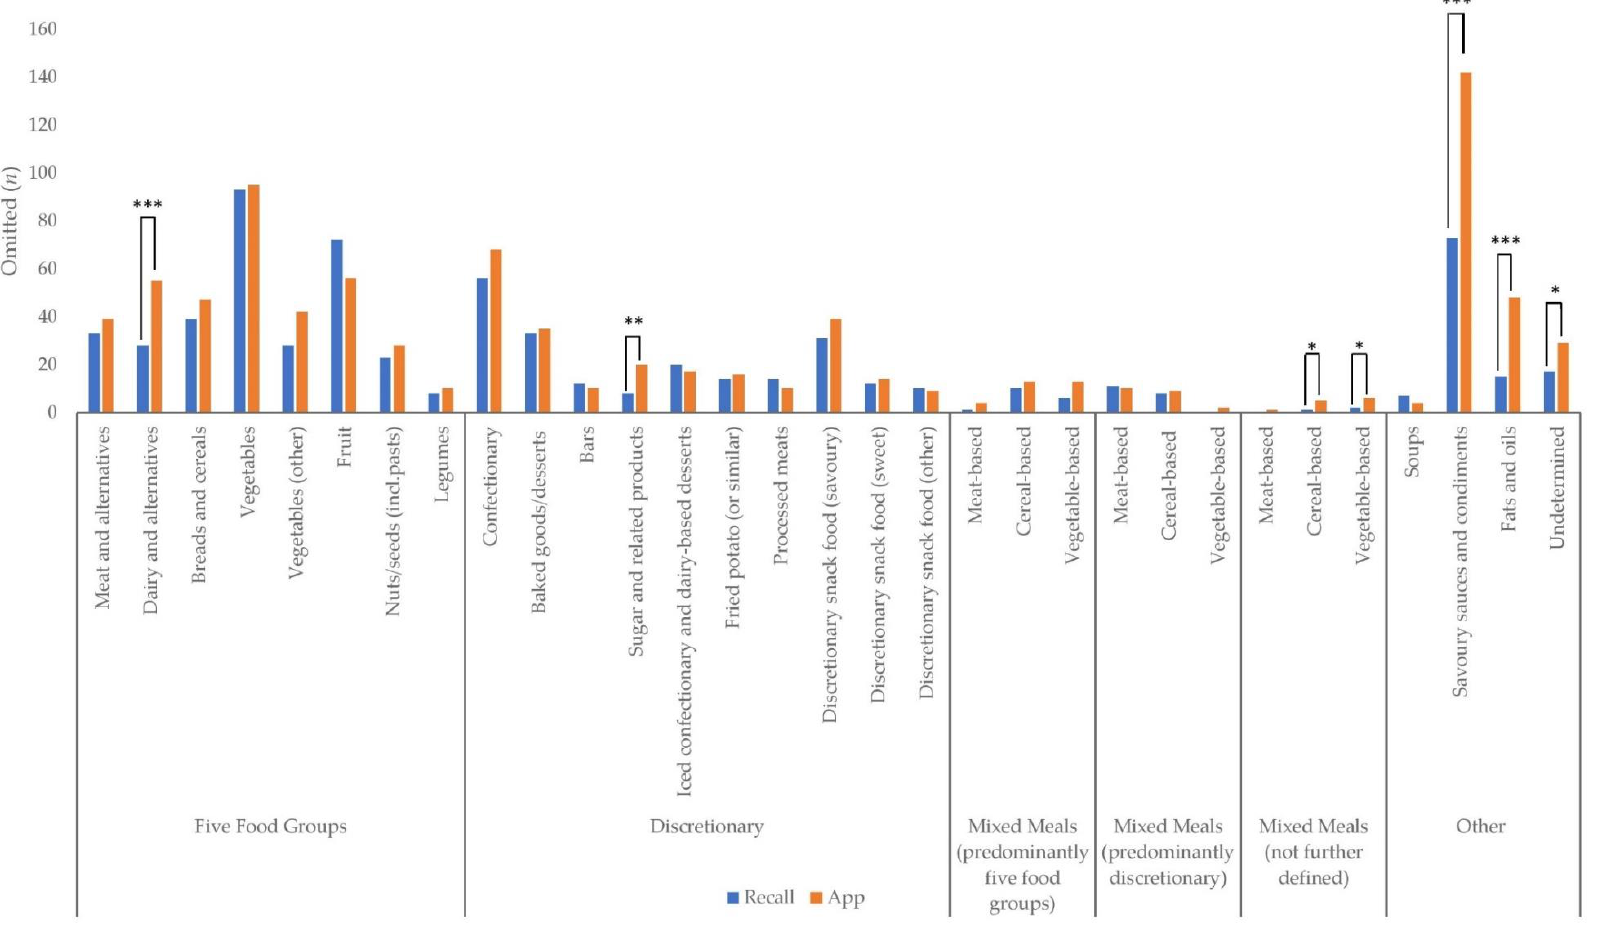
Figure 3. Frequency ( n ) of all food components and mixed meals omitted from dietitian-administered 24 h recall and app. Differences between 24 h recall and app that were statistically significant are indicated by bars: * p < 0.05, ** p < 0.01 ***, p ≤ 0.001.